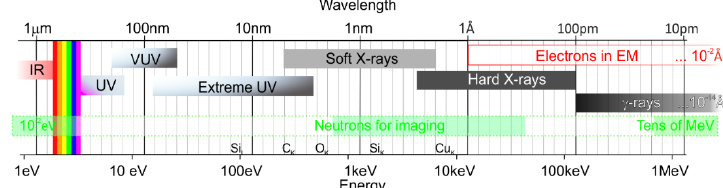
Figure 8. Electromagnetic spectrum from infrared (IR) to γ-rays and some probes for the magnetic imaging.